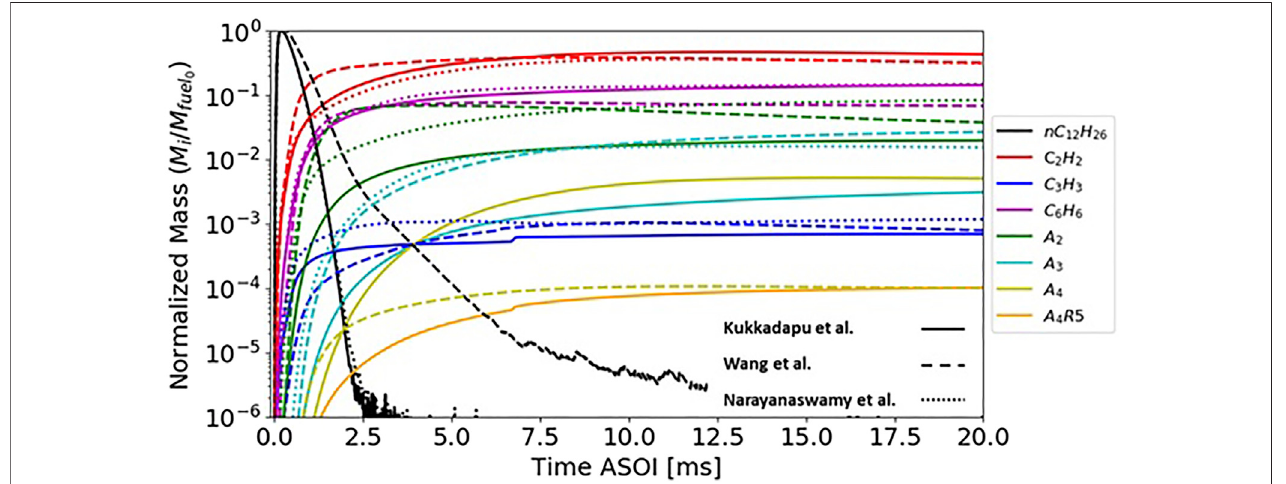
FIGURE 6 | The mass for a number of species normalized by the mass of injected fuel for simulations with the Kukkadapu et al. (2021), Wang et al. (2014) and Narayanaswamy et al. (2014) mechanisms with the PSM soot model versus time ASOI.